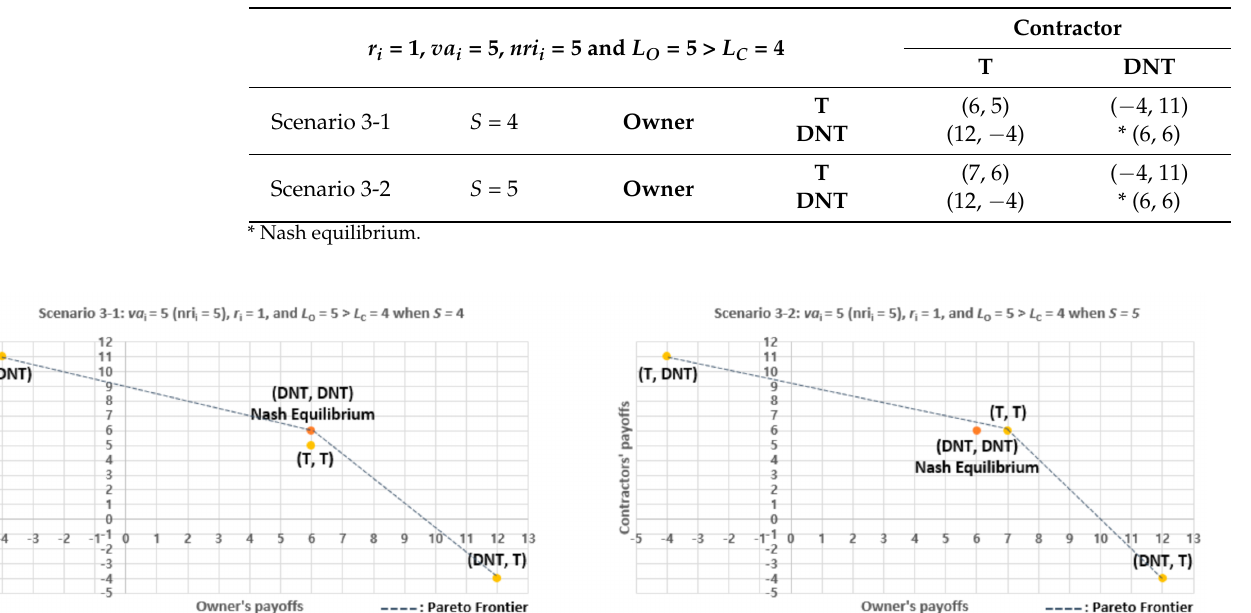
Table 8. Payoff matrix of Scenario 3.